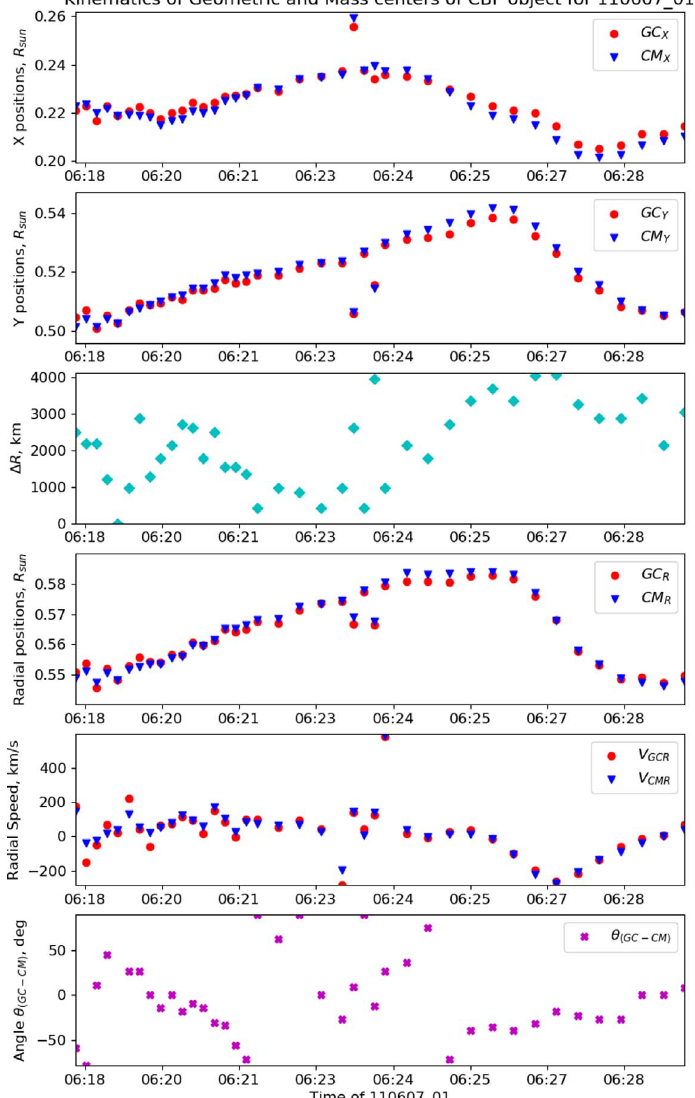
Fig. 15. Kinematics of the center of mass and geometric centers for the June 07, 2011 event. The panels are the same as in Figure